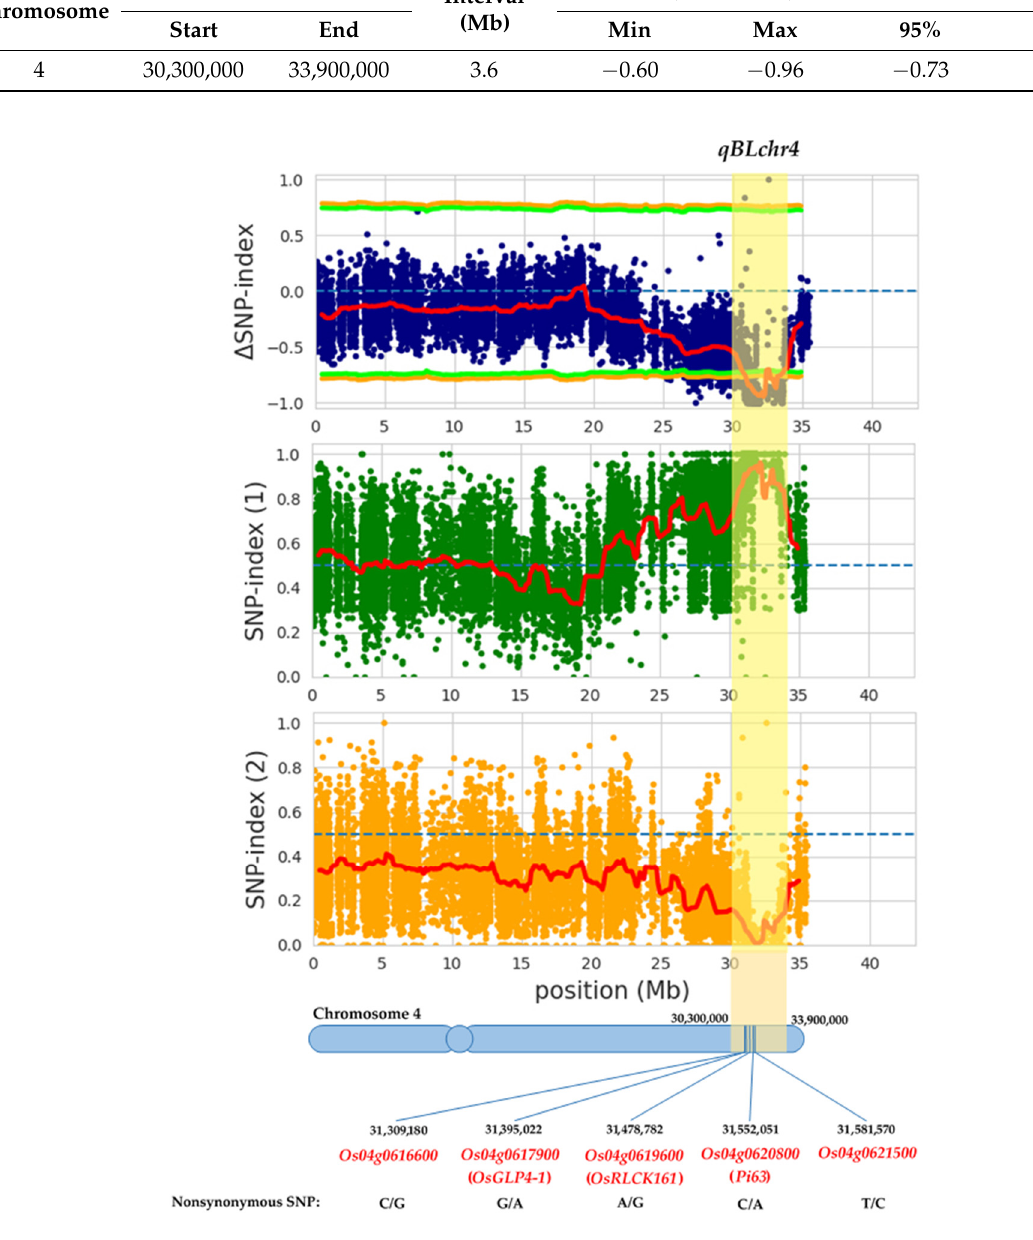
Figure 4. SNP index plots between resistance bulks (middle, BLR) and susceptible bulks (bottom, BLS) and ∆ (SNP index) plots (top) on chromosome 4. The cream shade highlights the detected QTL regions with contrasting SNP indexes in two bulks.